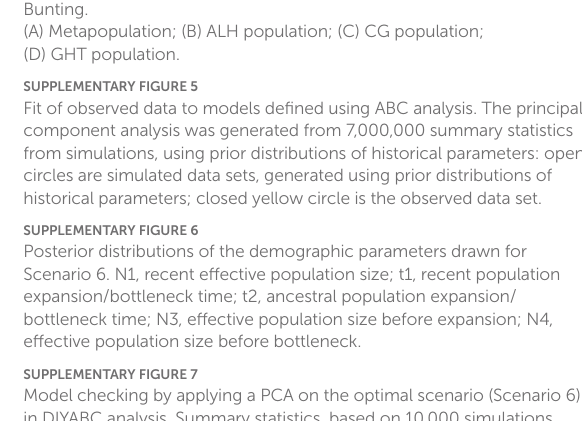
SUPPLEMENTARY FIGURE 1 Correlation between genetic (Codom genotypic genetic distance matrix) and geographic distances of five local populations inferred by Mantel test. SUPPLEMENTARY FIGURE 2 Distribution of differences between historical and contemporary migration rates for population comparisons (m c -m h ). The contemporary migration rate (m c ) is calculated by BayesAss, while the historical migration rate (m h ) is derived from Migrate-n. SUPPLEMENTARY FIGURE 3 Mismatch distribution analyses of Jankowski’s Bunting for mtDNA control region under constant population size model. (A) Metapopulation; (B) ALH population; (C) CG population; (D) GHT population. SUPPLEMENTARY FIGURE 4 Mode shift analysis based on allele frequency distribution in Jankowski’s Bunting. (A) Metapopulation; (B) ALH population; (C) CG population; (D) GHT population. SUPPLEMENTARY FIGURE 5 Fit of observed data to models defined using ABC analysis. The principal component analysis was generated from 7,000,000 summary statistics from simulations, using prior distributions of historical parameters: open circles are simulated data sets, generated using prior distributions of historical parameters; closed yellow circle is the observed data set. SUPPLEMENTARY FIGURE 6 Posterior distributions of the demographic parameters drawn for Scenario 6. N1, recent effective population size; t1, recent population expansion/bottleneck time; t2, ancestral population expansion/ bottleneck time; N3, effective population size before expansion; N4, effective population size before bottleneck. SUPPLEMENTARY FIGURE 7 Model checking by applying a PCA on the optimal scenario (Scenario 6) in DIYABC analysis. Summary statistics, based on 10,000 simulations, visualize the fit between the simulated and the observed datasets. SUPPLEMENTARY TABLE 6 Raw data of microsatellite genotype. The numbers in the table indicate the length of